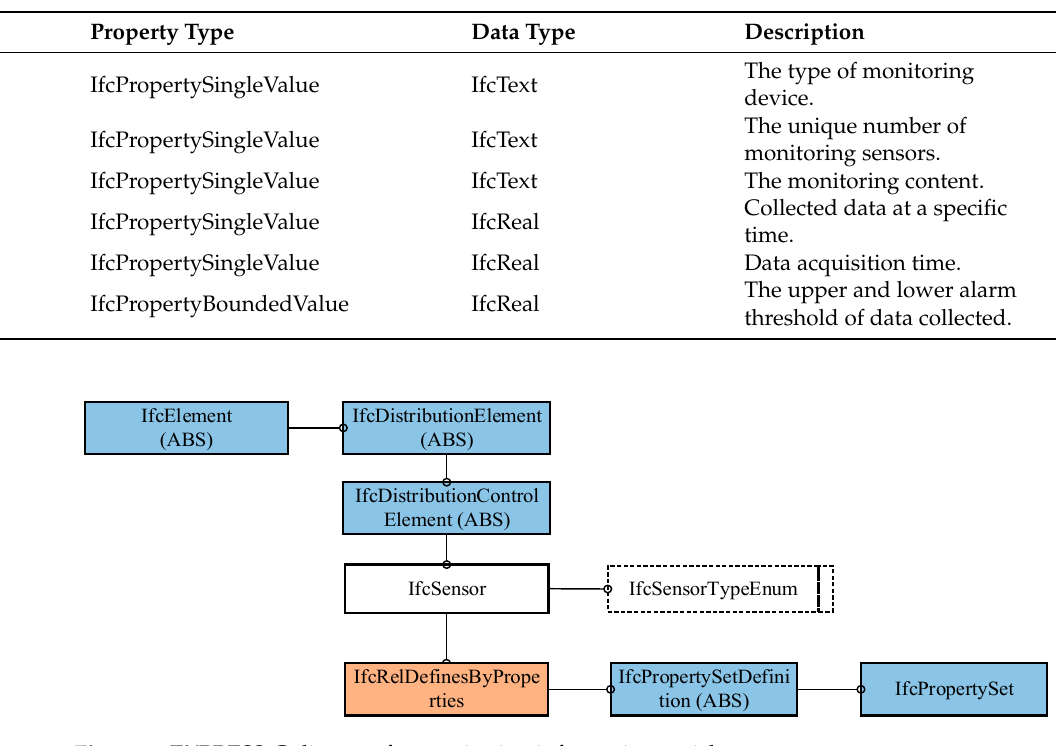
Figure 3. EXPRESS-G diagram for monitoring information enrichment.